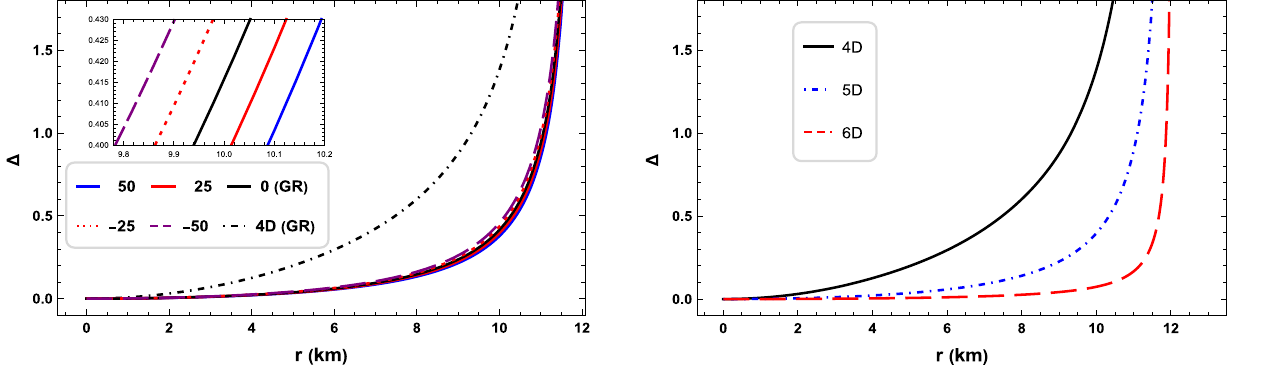
Fig. 6 Radial variation of anisotropy factor ( (cid:11) ) in PSR J0348+0432 for different α values in 5D